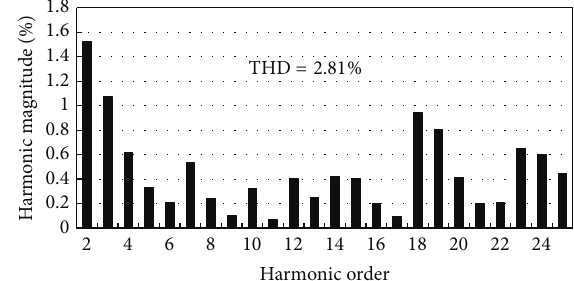
Figure 10: Experimental back EMF harmonic analysis of phase A.